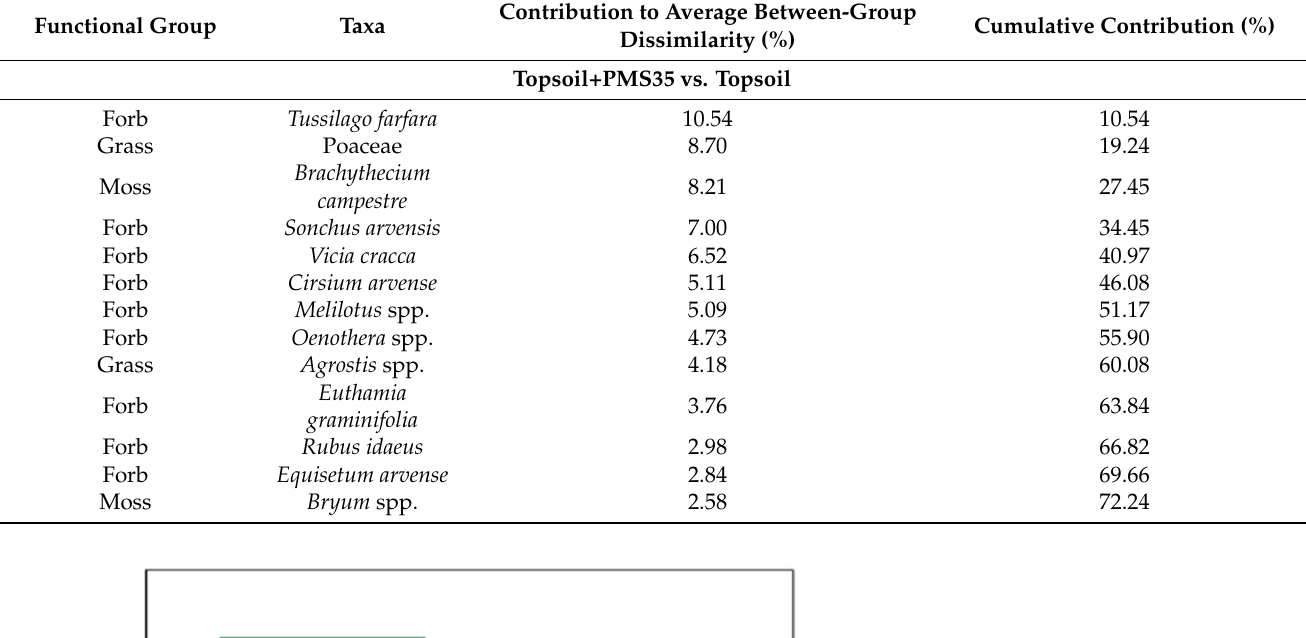
Figure 2. Non ‐ metric multidimensional scaling (NMDS) representation of community structure in relation to the effect of amendment application (topsoil+PMS35 and topsoil) at the Niobec site. El ‐ lipses represent 95% confidence intervals.